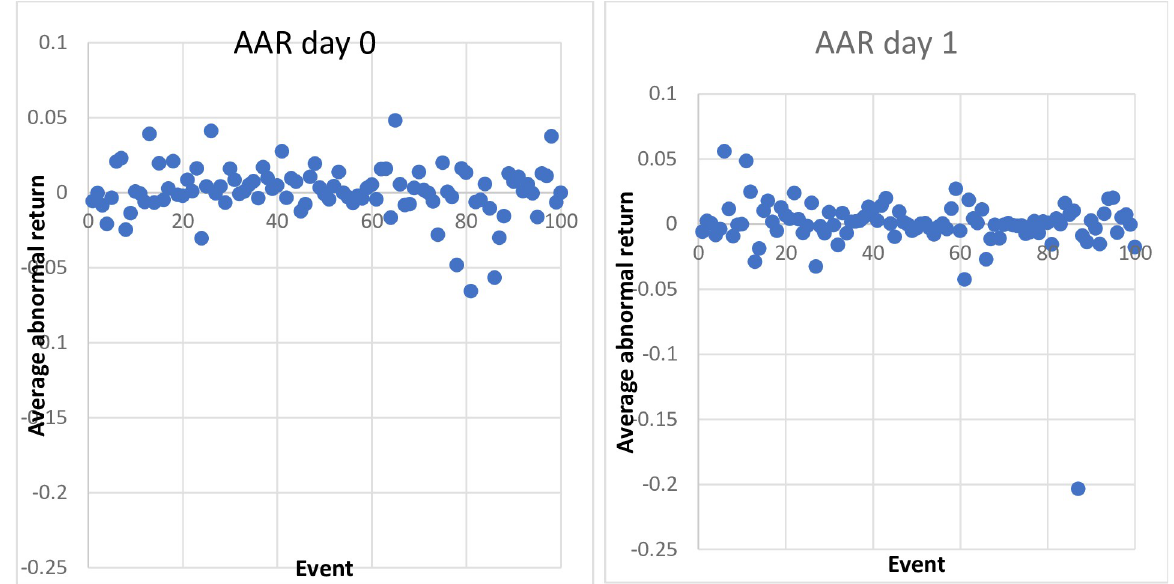
Fig 1. Average abnormal stock market returns in percentages on days 0 and 1 for all events.